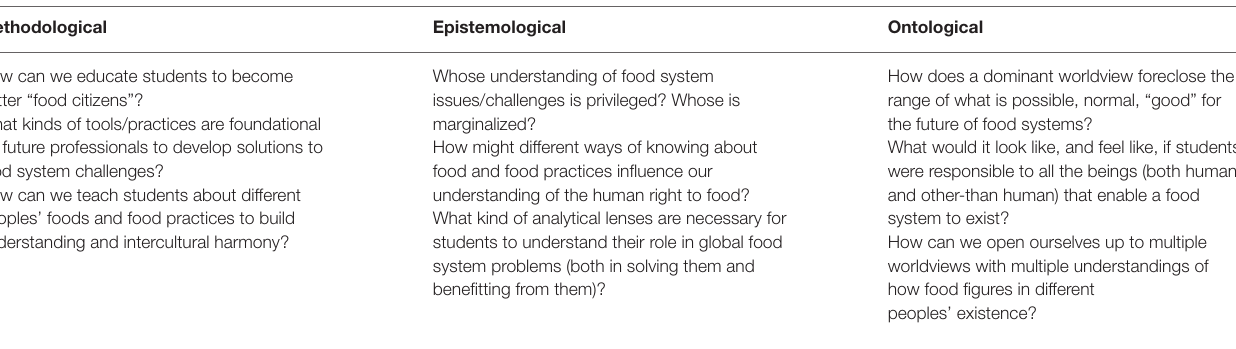
TABLE 1 | Example questions for different educational interventions in food systems education. Methodological Epistemological